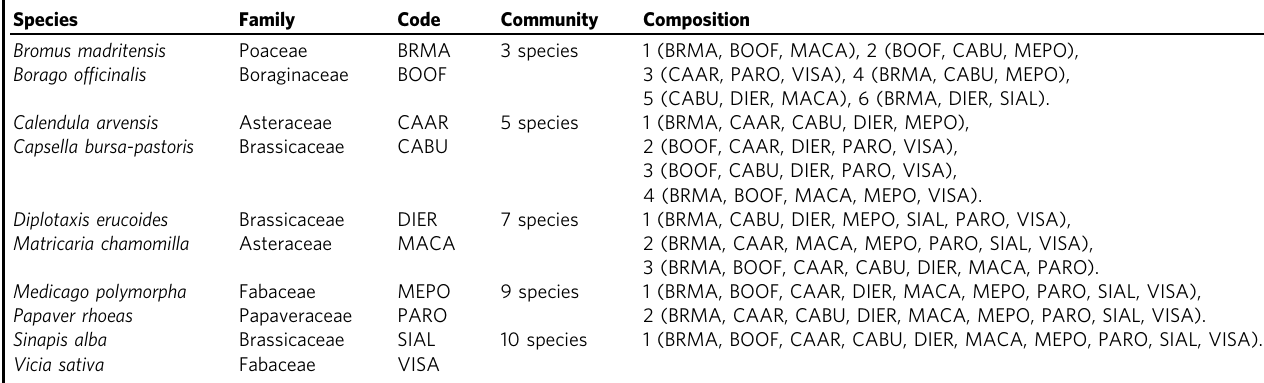
Table 1 Species and assembled communities with the diversity levels used in the experiment.